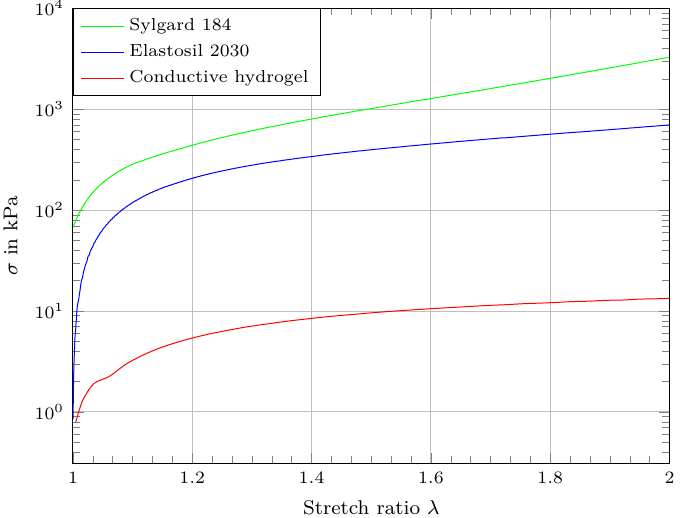
Figure 7. Comparison of stretch–stress properties between the used polymer materials in logarith- mic